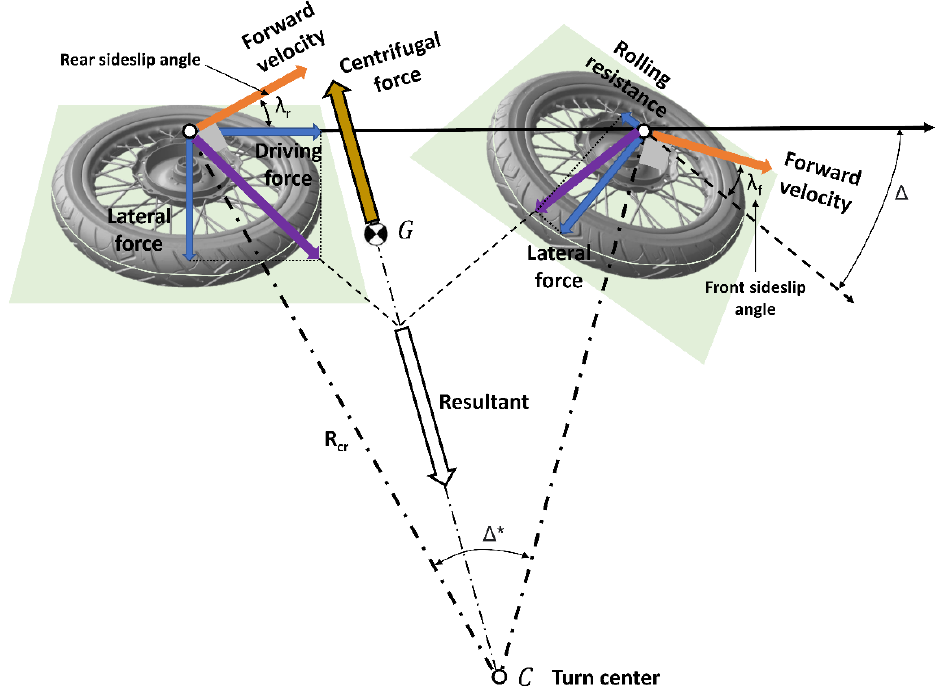
Figure 1. Forces acting on PTW vehicle during curvilinear trajectory with non-zero sideslip angle.